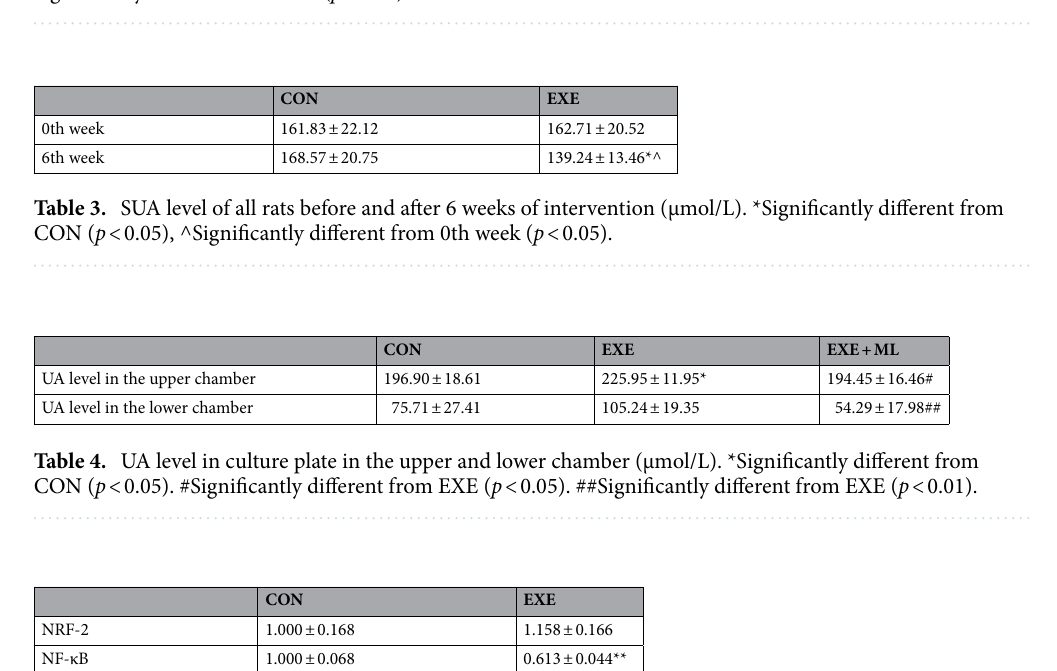
Figure 1. ( A ) SUA of all rats before and after 6 weeks of intervention obtained either with exercise (EXE) or without exercise (CON). ( B ) XOD level of all rats after 6 weeks of intervention in serum and liver. ( C ) UA level of the upper chamber in culture plate. ( D ) UA level of the lower chamber in culture plate. Data are means ± SD (n = 10). * Significantly different from CON ( p < 0.05), ^ Significantly different from 0th week ( p < 0.05), ## Significantly different from EXE ( p < 0.01).